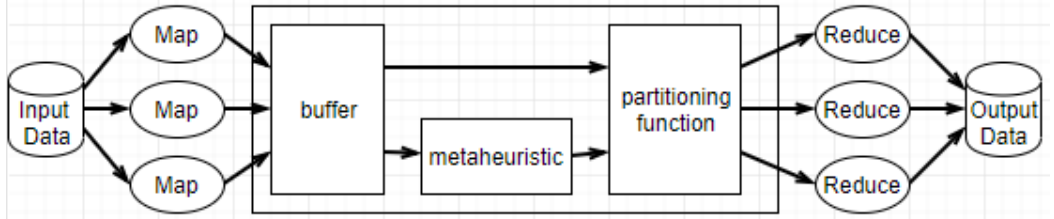
Figure 6. MAPSKEW